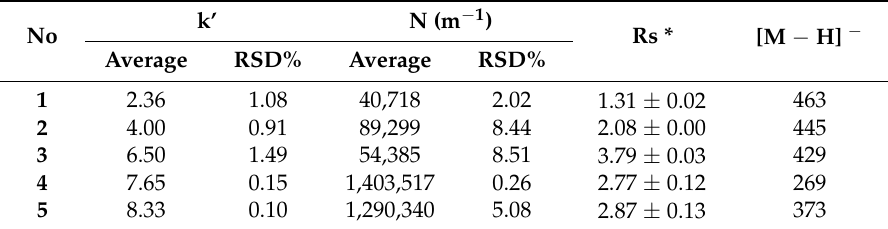
Figure 4. Chromatogram of the leaf of S. baicalensis recorded at 280 nm ( A ), 335 nm ( B ) and the UV spectra of compounds u, I and 1 ( C ). Compound 1 has a maximum absorption at 335 nm, whereas the absorption of compound u is very low. The chromatographic signal of compound u was not observed when the chromatogram was recorded at 335 nm. 1 = Scutellarin; u = unknown compound; I = 8-arabinosyl-6-glucosyl-5,7-dihydroxyflavone. Table 1. Chromatographic parameters of compounds 1–5 ( n =